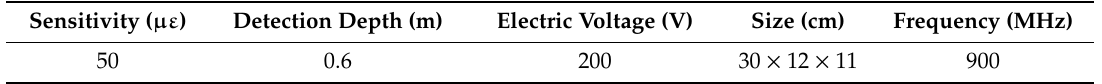
Figure 6. Schematic of the physical model for the test. Table 1. Parameters of the ground penetrating radar (GPR).